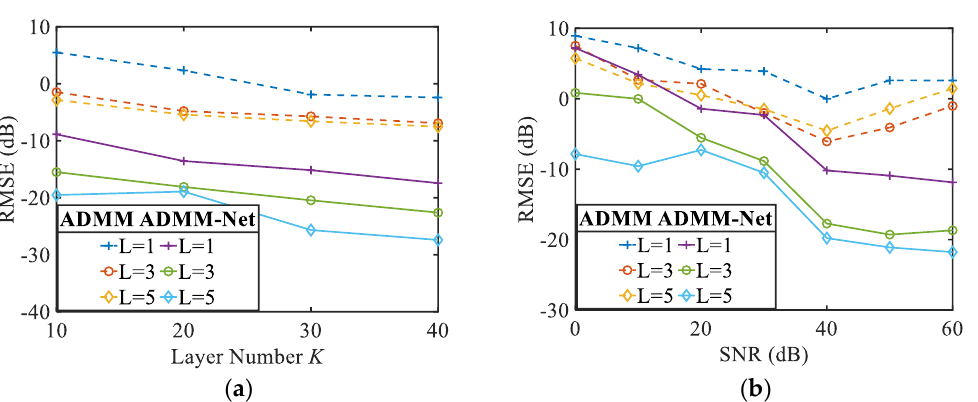
Figure 7. Test RMSEs versus K and SNR. ( a ) versus network layer K ; ( b ) versus SNR.